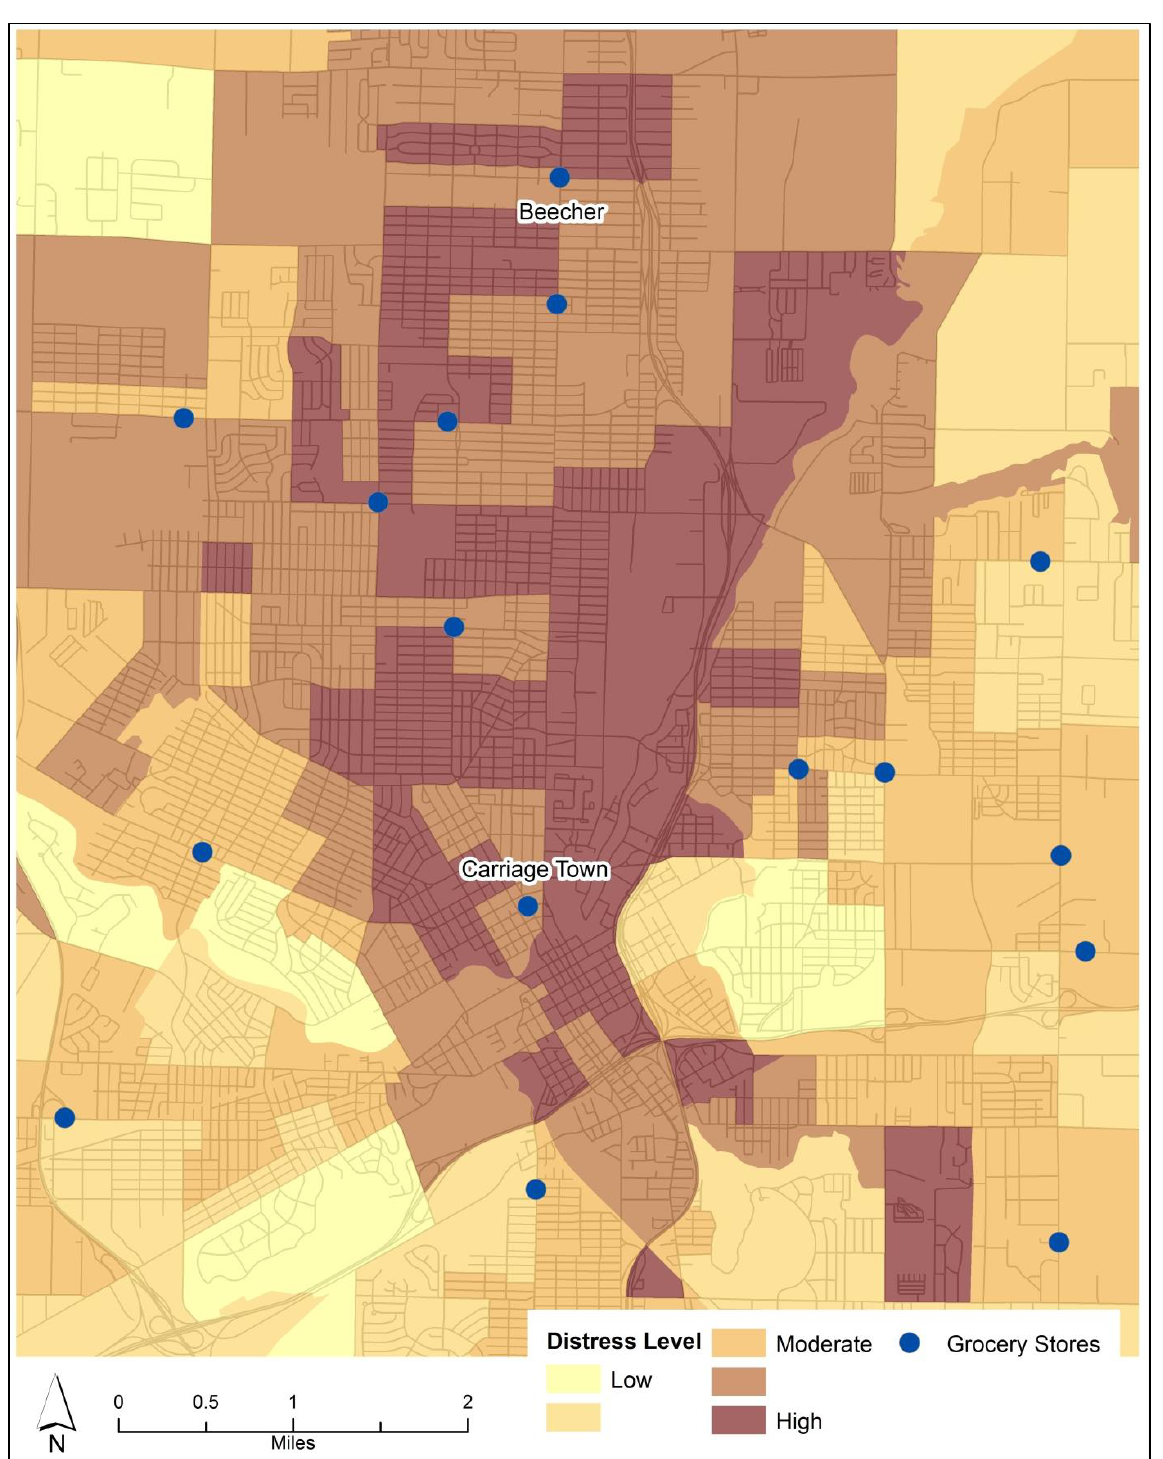
Figure 2. Level of Socioeconomic Distress by Census Block Group (US Census Bureau, 2000)